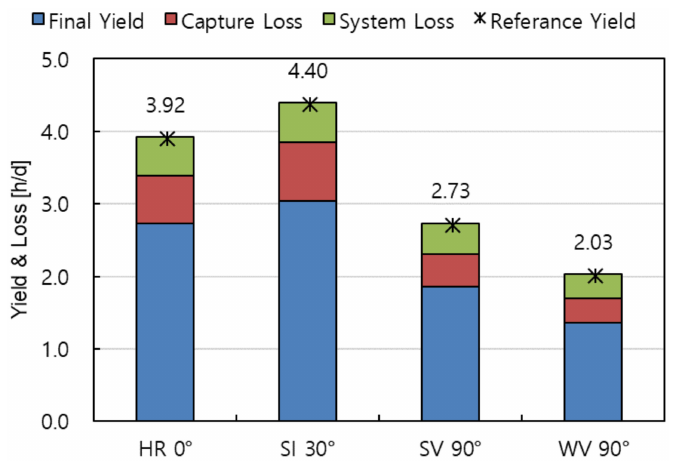
Figure 3. Annual yield and loss of each